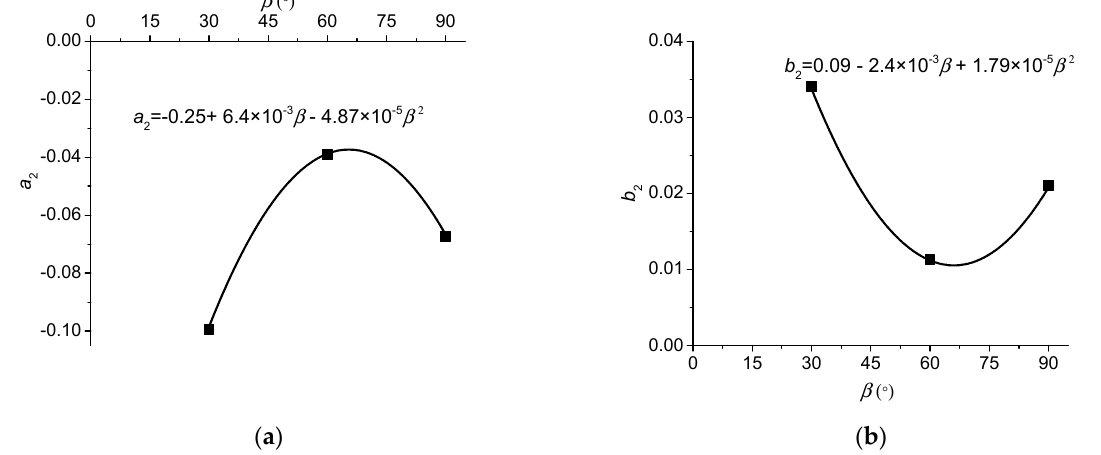
Figure 15. Fitting of constant parameters ( a ) a 2 and ( b ) b 2 dependent on the inclination angle β . It